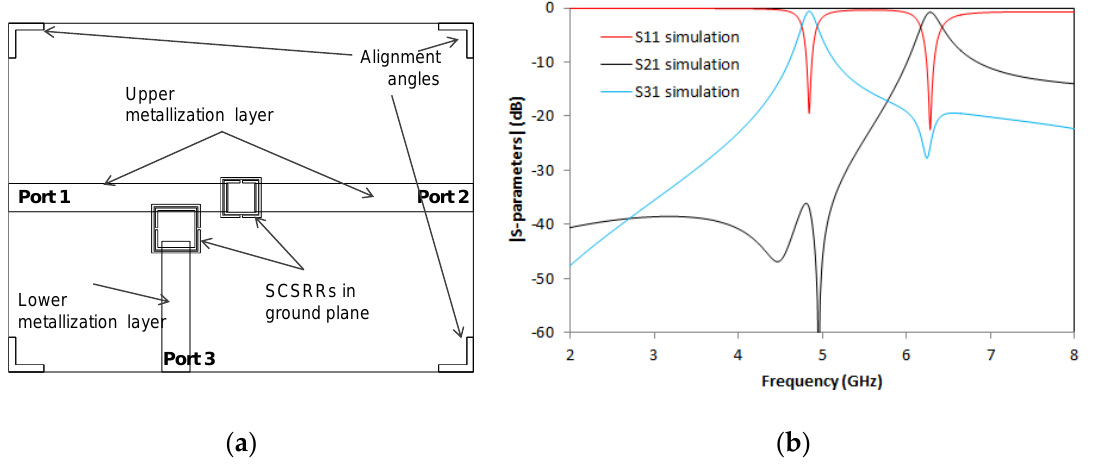
Figure 20. ( a ) Top view overlapped layer distribution of a 2-layer duplexer. ( b ) Simulated S11 (dashed red line), simulated S21 (dashed black line), and simulated S31 (dashed blue line).